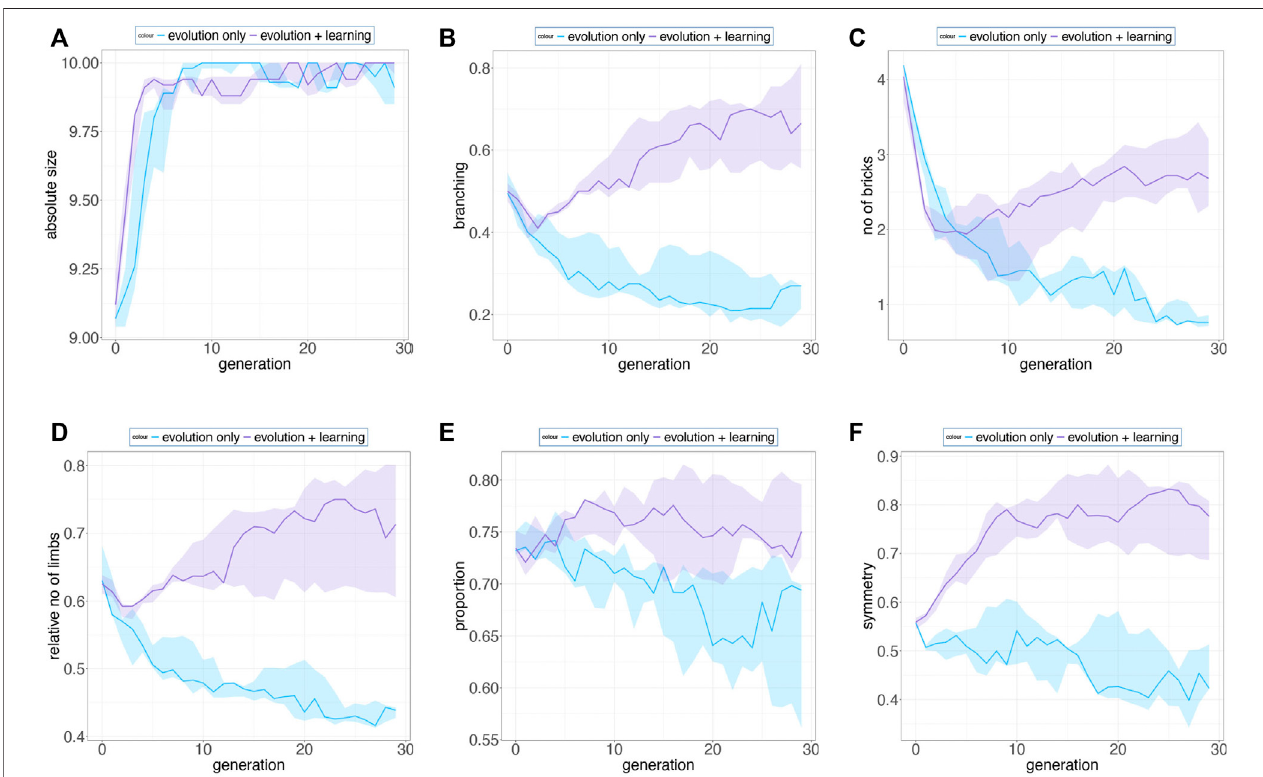
FIGURE 10 | We selected 6 morphological traits that display a clear trend over generations and present the progression of their means averaged over 10 runs for theentirepopulation.Shaded regionsdenotea95%bootstrappedcon fi denceinterval. (A) ,robotsfromboth methods tendtodevelopbiggersizesovergenerations (B) (D) , branching parameter and the relative no. of limbs from Evolution + Learning are increasing along the evolutionary timeline, however Evolution-Only evolved in an opposite manner (C) (F) , Evolution + Learning robots tend to be more symmetric and have more bricks as they evolved compared to robots evolved in Evolution- Only (E) , proportions from both methods show slightly decreasing trends, and the ratio of width and length of the robot morphology in Evolution + Learning is slightly higher over generations.